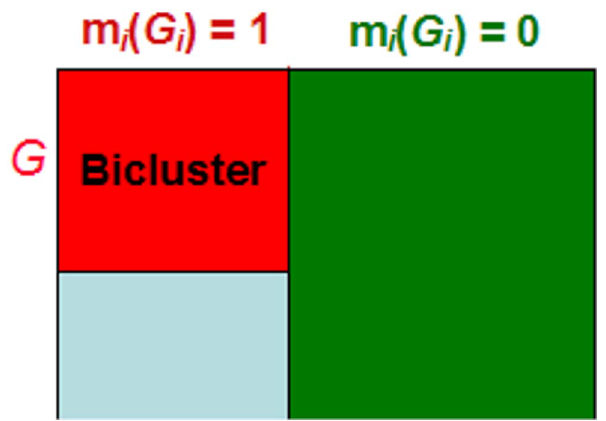
Figure 1. Subgroup-specific binary classifier. For each bicluster C where I is an indicator function.